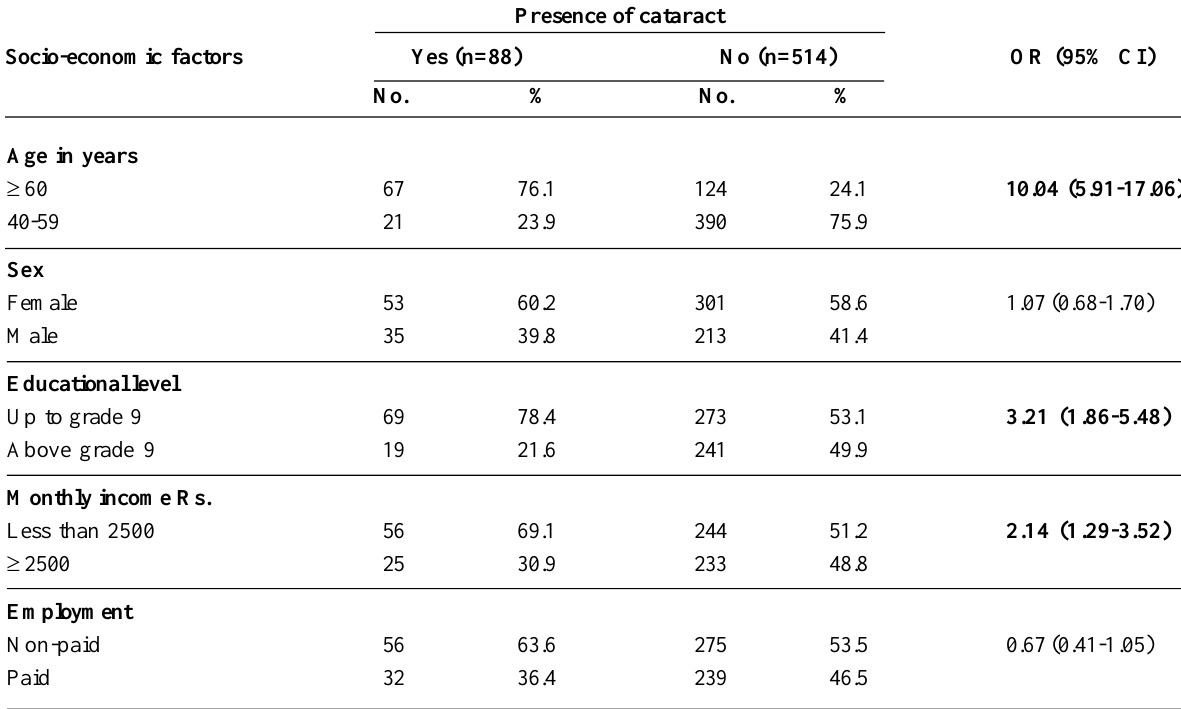
Table 1. Distribution of the study sample by cataract and socio-economic factors